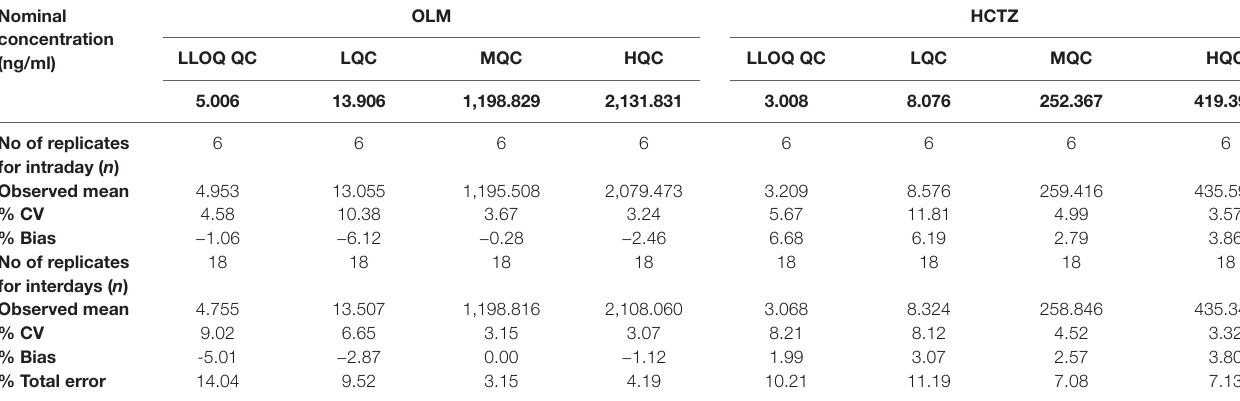
TABLE 4 | Intraday and interday precision and accuracy for the detection of OLM and HCTZ in human plasma. Nominal concentration (ng/ml)